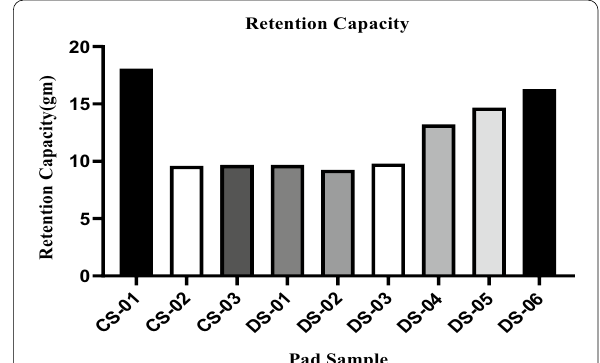
Fig. 10 Retention capacity after centrifugation (gm) of various samples